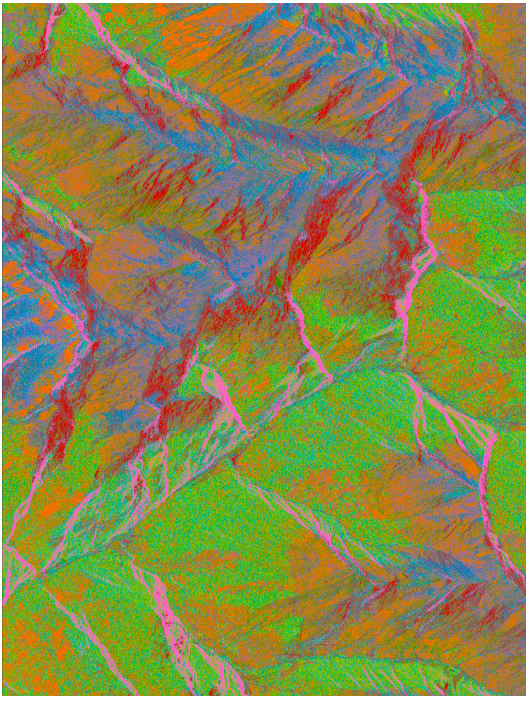
Figure 11. Clustering of the Guil basin image into 10 classes obtained from the CAE space in dimension